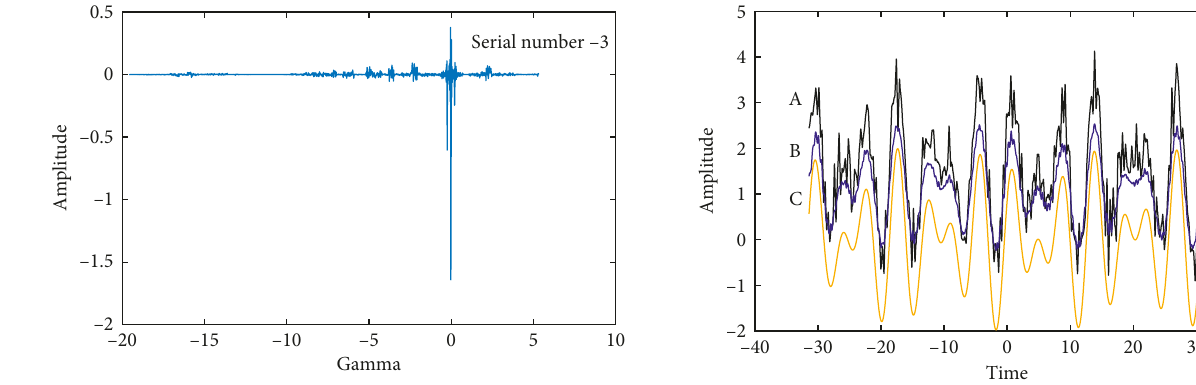
Figure 14: The real part of the new negative filtered signal in the frequency domain.